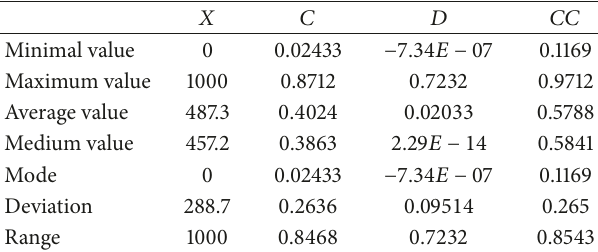
Table 13: The statistical analyses of strategies 𝐶 , 𝐷 , and 𝐶𝐶